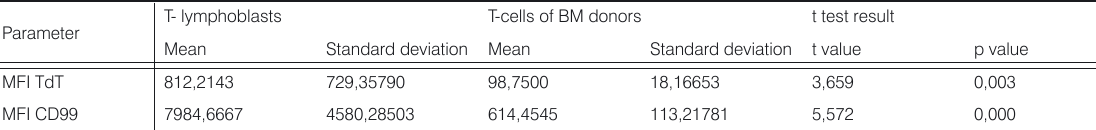
Table 2. Comparison of TdT and CD99 MFI between T-lymphoblasts and T-cells of BM donors using t value.